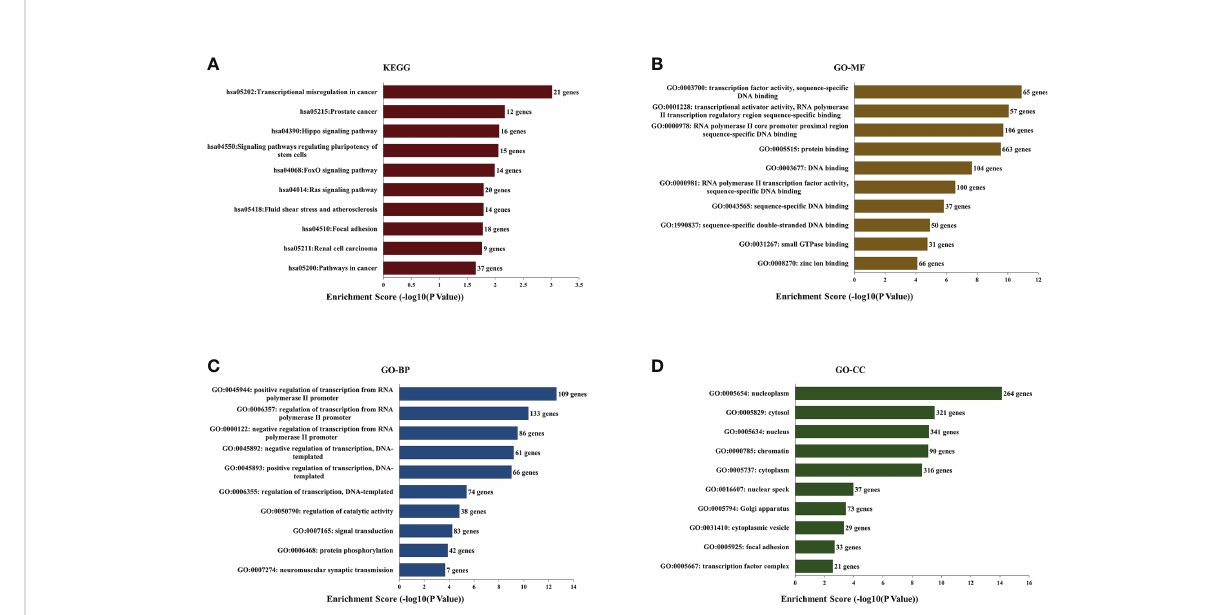
FIGURE 5 Kyoto Encyclopedia of Genes and Genomes (KEGG) pathway and Gene Ontology (GO) functional enrichment analysis of the predicted target genes from has_circRNA_0007990. (A) KEGG. (B) GO-molecular functions. (C) GO-biological processes. (D) GO-cell